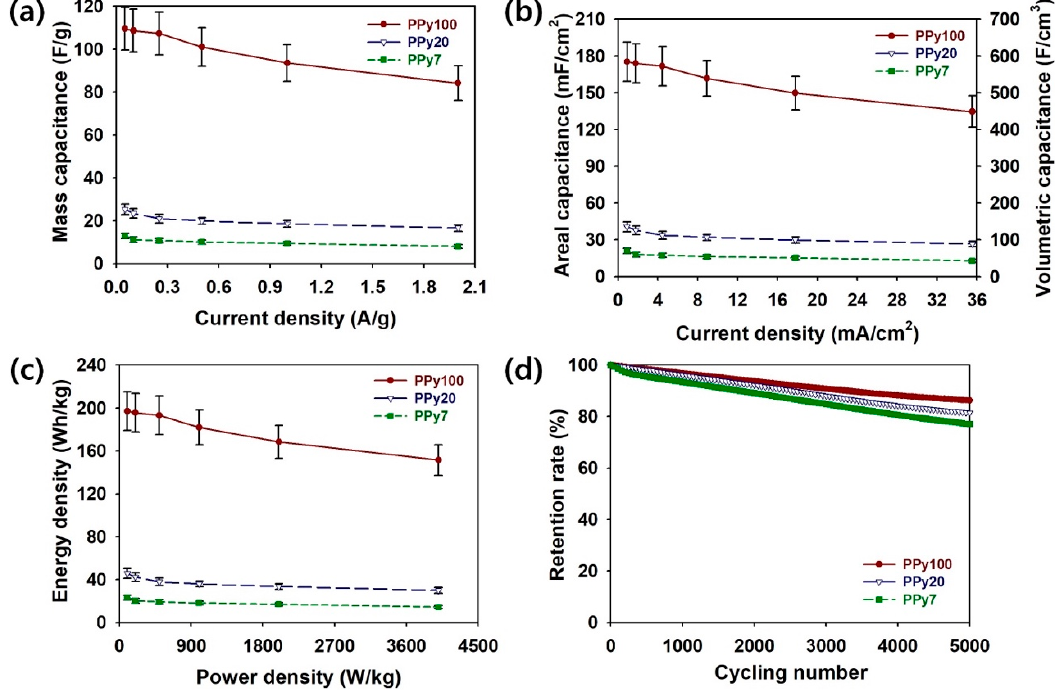
Figure 7. ( a ) Plots of the mass capacitance (F/g) of coin cells containing Polypyrrole:Poly(4-styrenesulfonate (PPy:PSS) with different average molecular weights at different current densities. ( b ) Plots of the areal capacitance (mF/cm 2 ) and volumetric capacitance (F/cm 3 ) of coin cells containing PPy:PSS with different average molecular weights at different current densities. ( c ) Ragone plots of the energy density versus the power density of coin cells containing PPy:PSS with different average molecular weights. ( d ) The cycling stability of coin cells containing PPy:PSS with different average molecular weights.